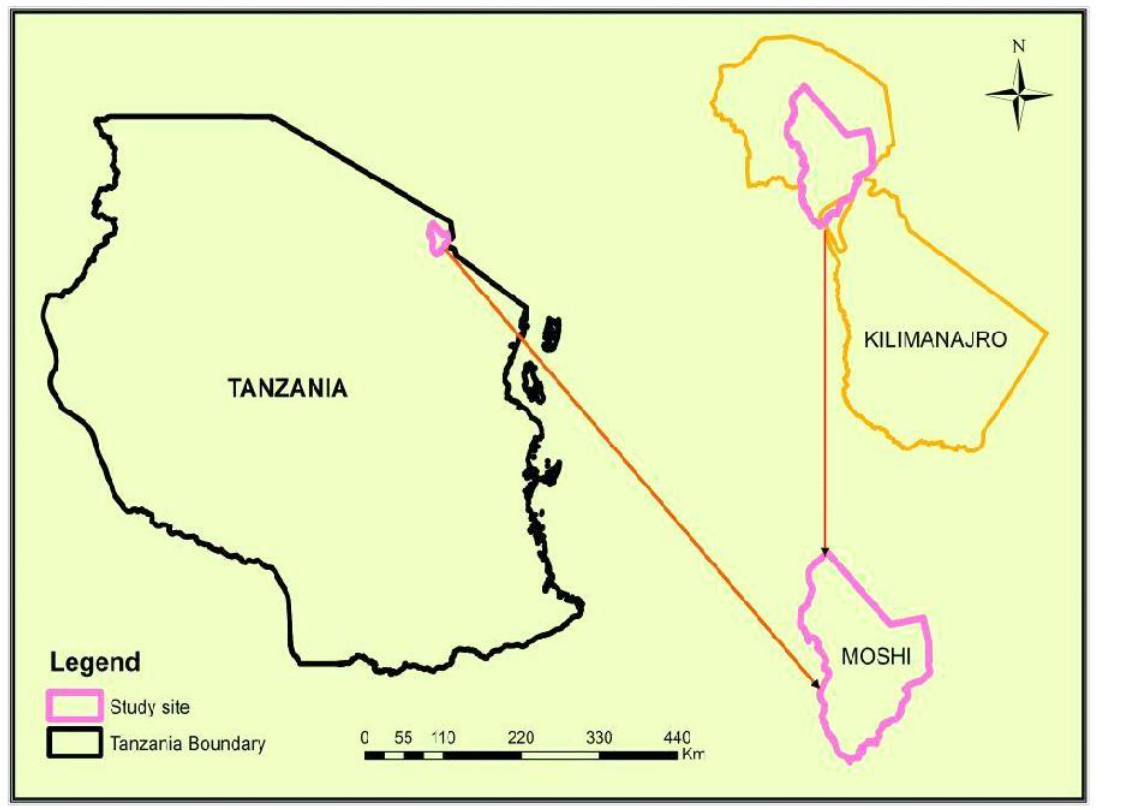
Fig. 1: The location of Kilimanjaro